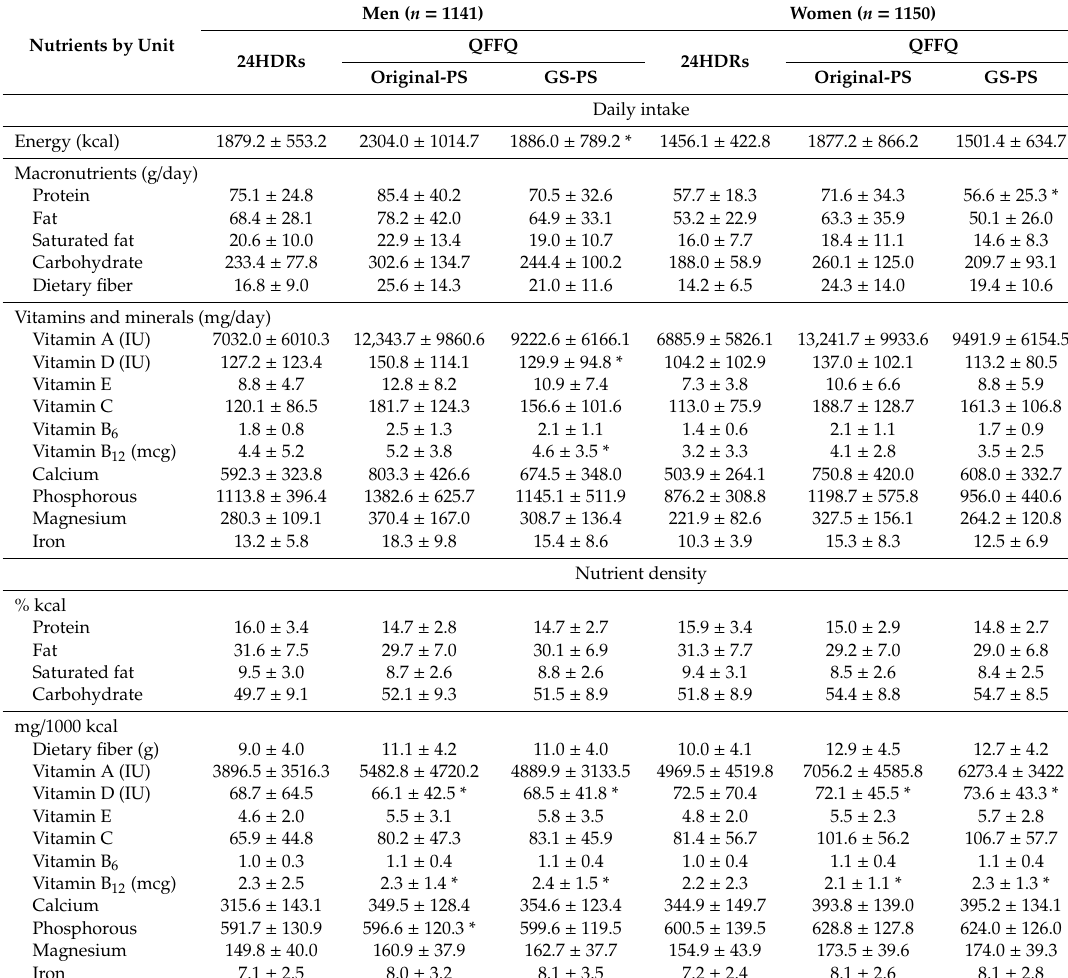
Table 4. Daily nutrient intakes (absolute and as densities) estimated from 24 h dietary recalls (24HDRs) and from the quantitative food frequency questionnaire (QFFQ) using either an original-portion size or a gender specific-portion size in the calibration study of the Multiethnic Cohort.